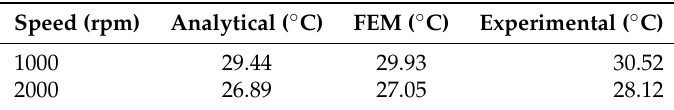
Table 4. PM temperature